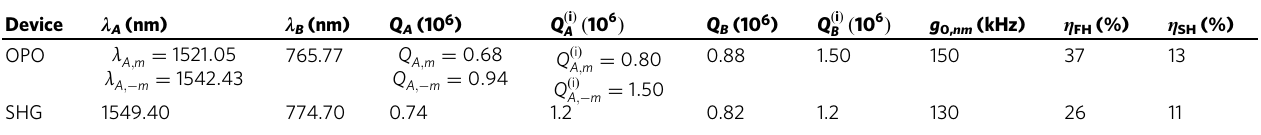
Table 1 Summary of the measured device parameters.